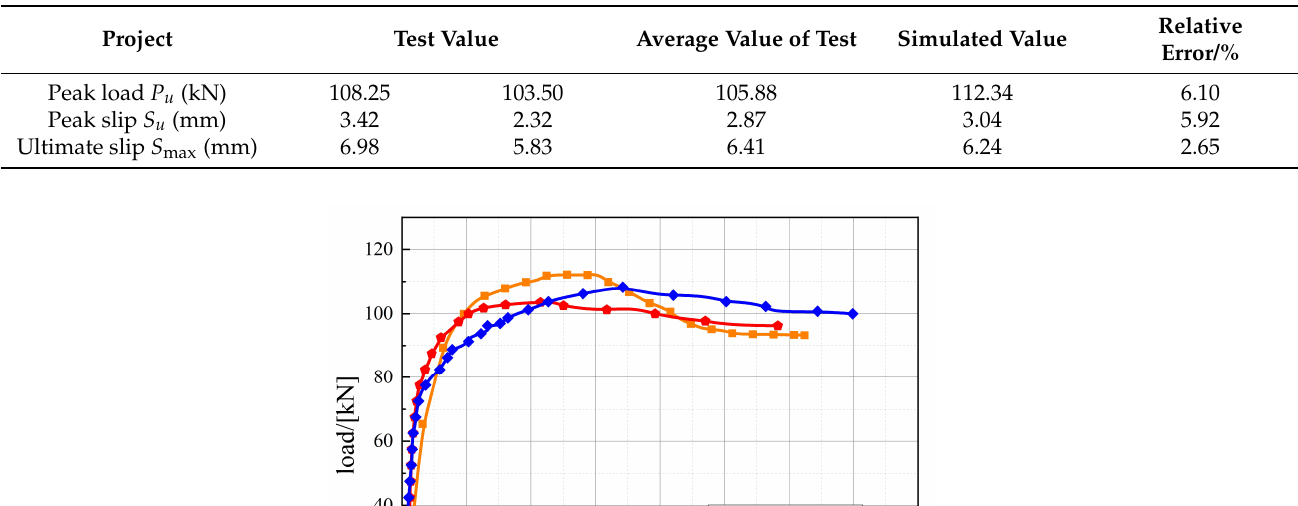
Table 8. Comparison between the simulated and experimental result.